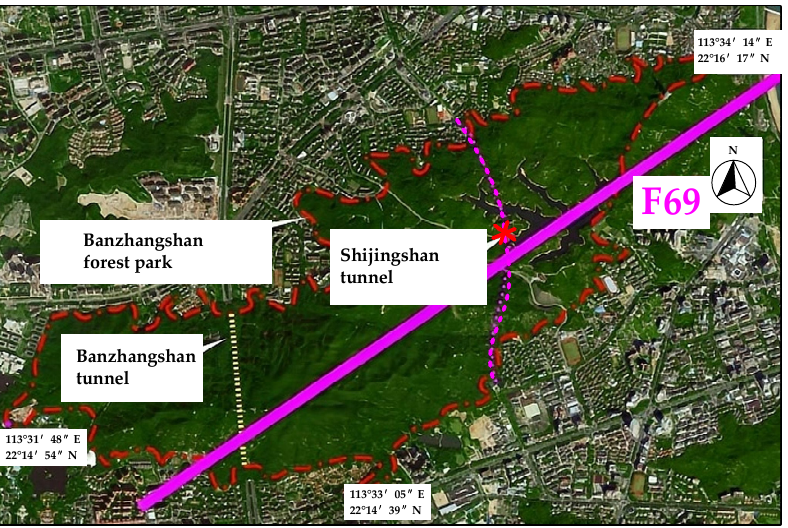
Figure 8. The intersection of Shijingshan tunnel and F69 is near Jida reservoir. (https://zhuanlan.zhihu.com/p/390890982, accessed on 18 January 2022).